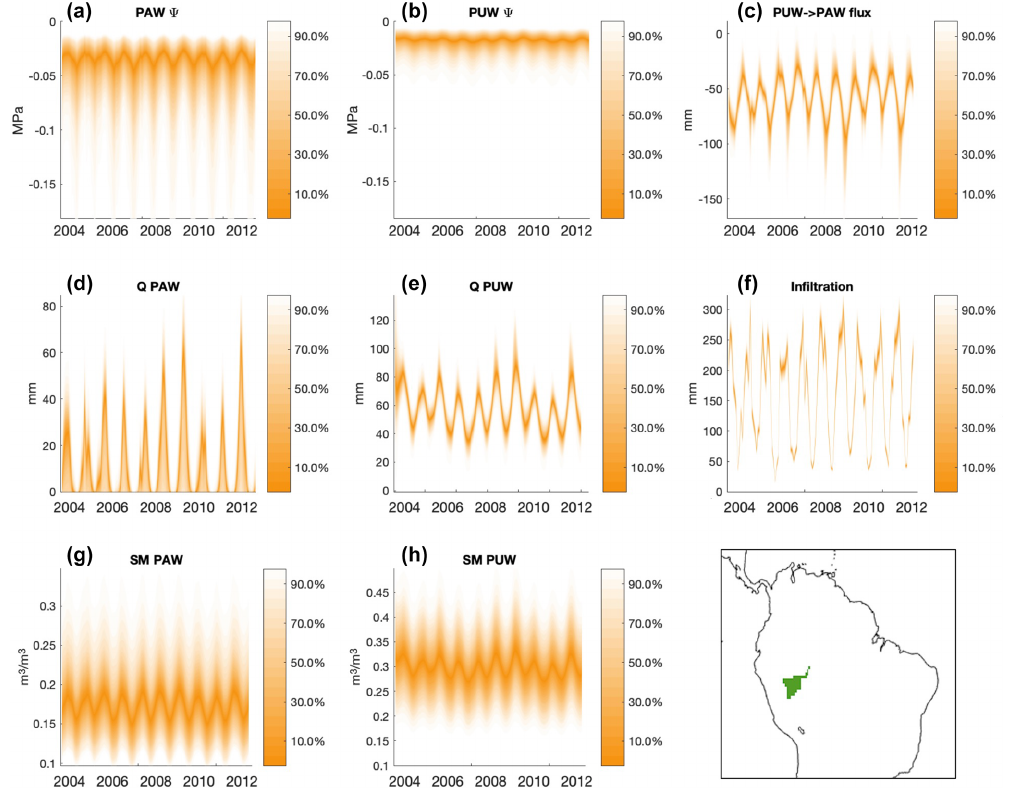
Figure 5. GRACE-informed model-simulated states and fluxes for the Gavião watershed (basin shown in the bottom right panel in the context of the broader South American domain). These figures show specific model processes, such as (a) the matric potential of plant available water (PAW ψ ), (b) the matric potential of plant unavailable water (PUW ψ ), (c) recharge (PUW- > PAW flux) where negative values indicate a downward flux, (d) discharge from the top layer ( Q PAW), (e) discharge from the bottom layer ( Q PUW), (f) infiltration, (g) soil moisture of the top layer (SM PAW), and (h) soil moisture of the bottom layer (SM PUW). The ranges shown here in orange envelopes indicate the GRACE-informed posterior ranges. A map showing the location of the Gavião watershed is shown in the bottom right